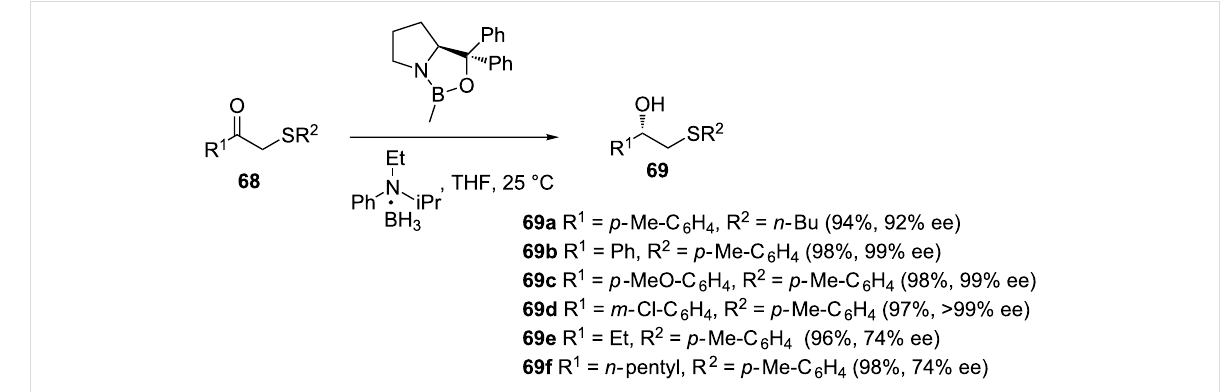
also been explored. Cho and co-workers reported a CBS-oxaza- borolidine-catalyzed asymmetric borane reduction of β